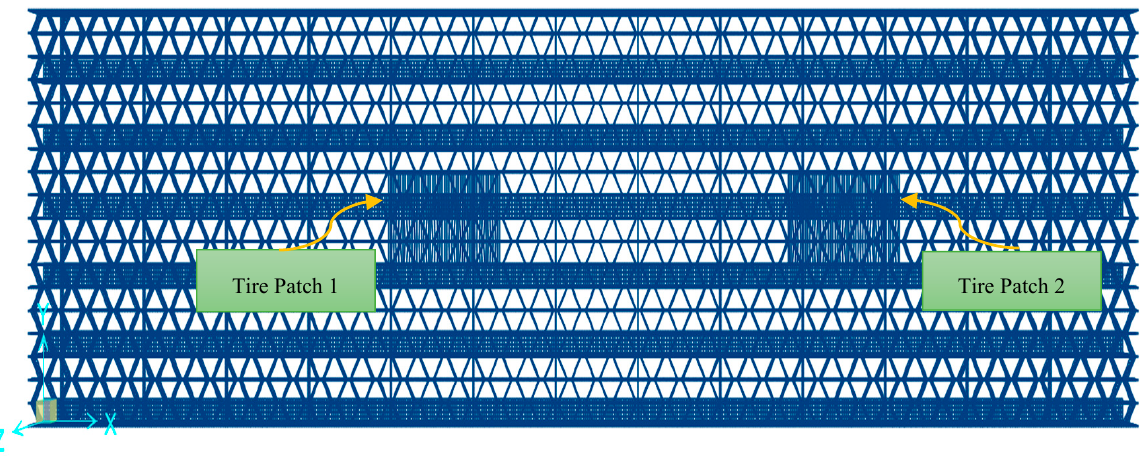
Figure 2. Finite element model of the 37R5 L-series panel